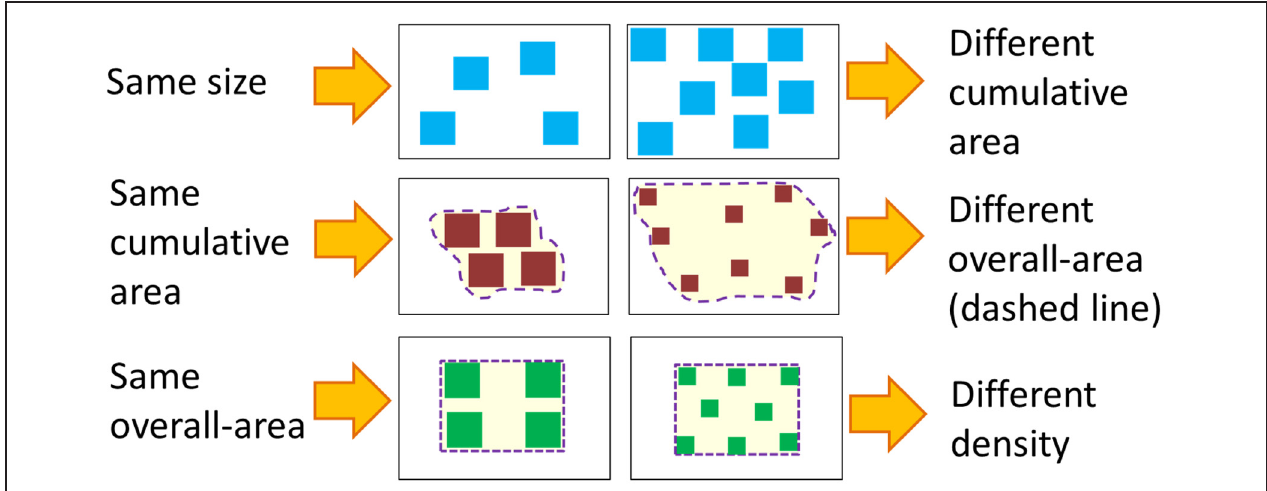
FIGURE 1 | Illustration—Controlling continuous magnitudes. Controlling for one continuous magnitude always changes other continuous magnitudes.